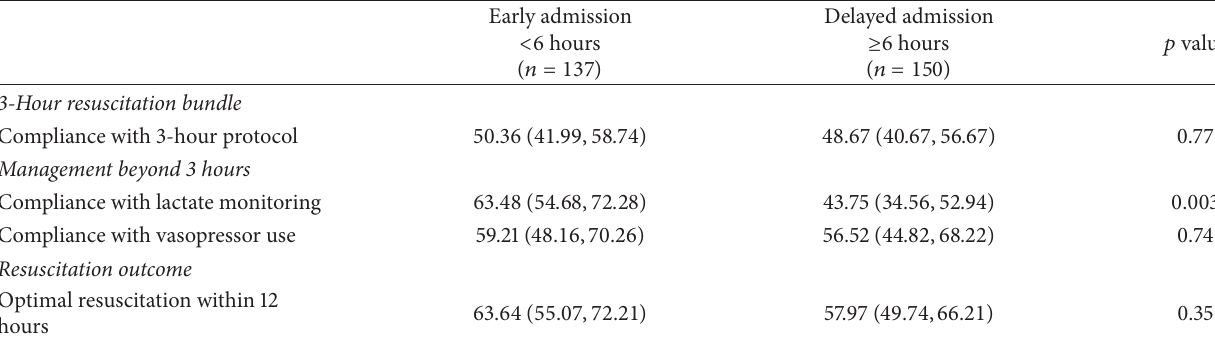
Table 3: Compliance with sepsis bundles and optimal resuscitation within 12 hours.